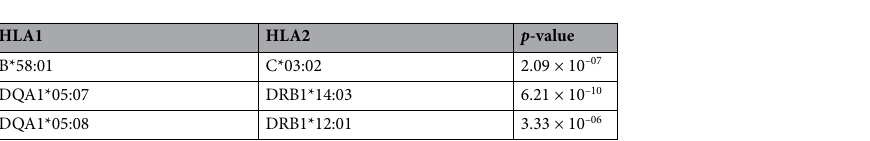
Table 4. Linkage disequilibrium between HLA alleles observed to be associated with sarcoidosis in Koreans. HLA human leukocyte antigen.